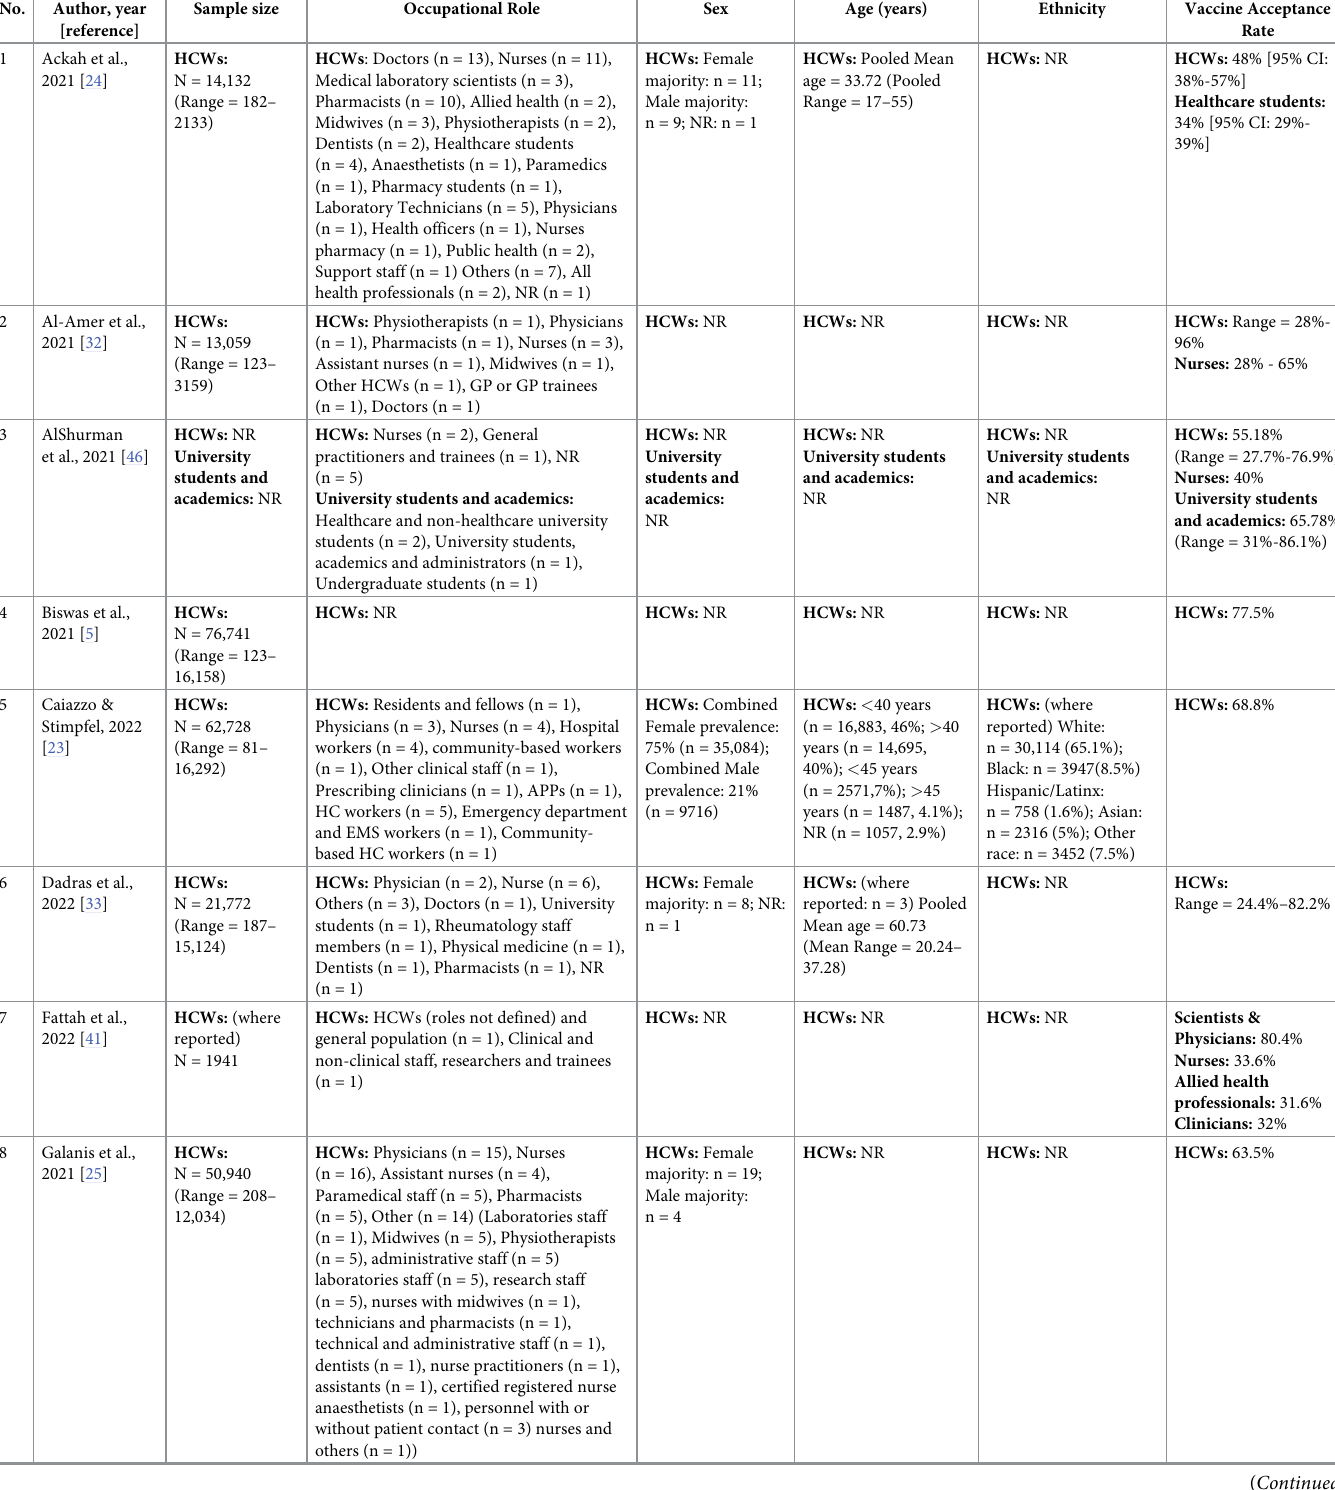
Table 4. Sociodemographic characteristics of populations included in the Umbrella